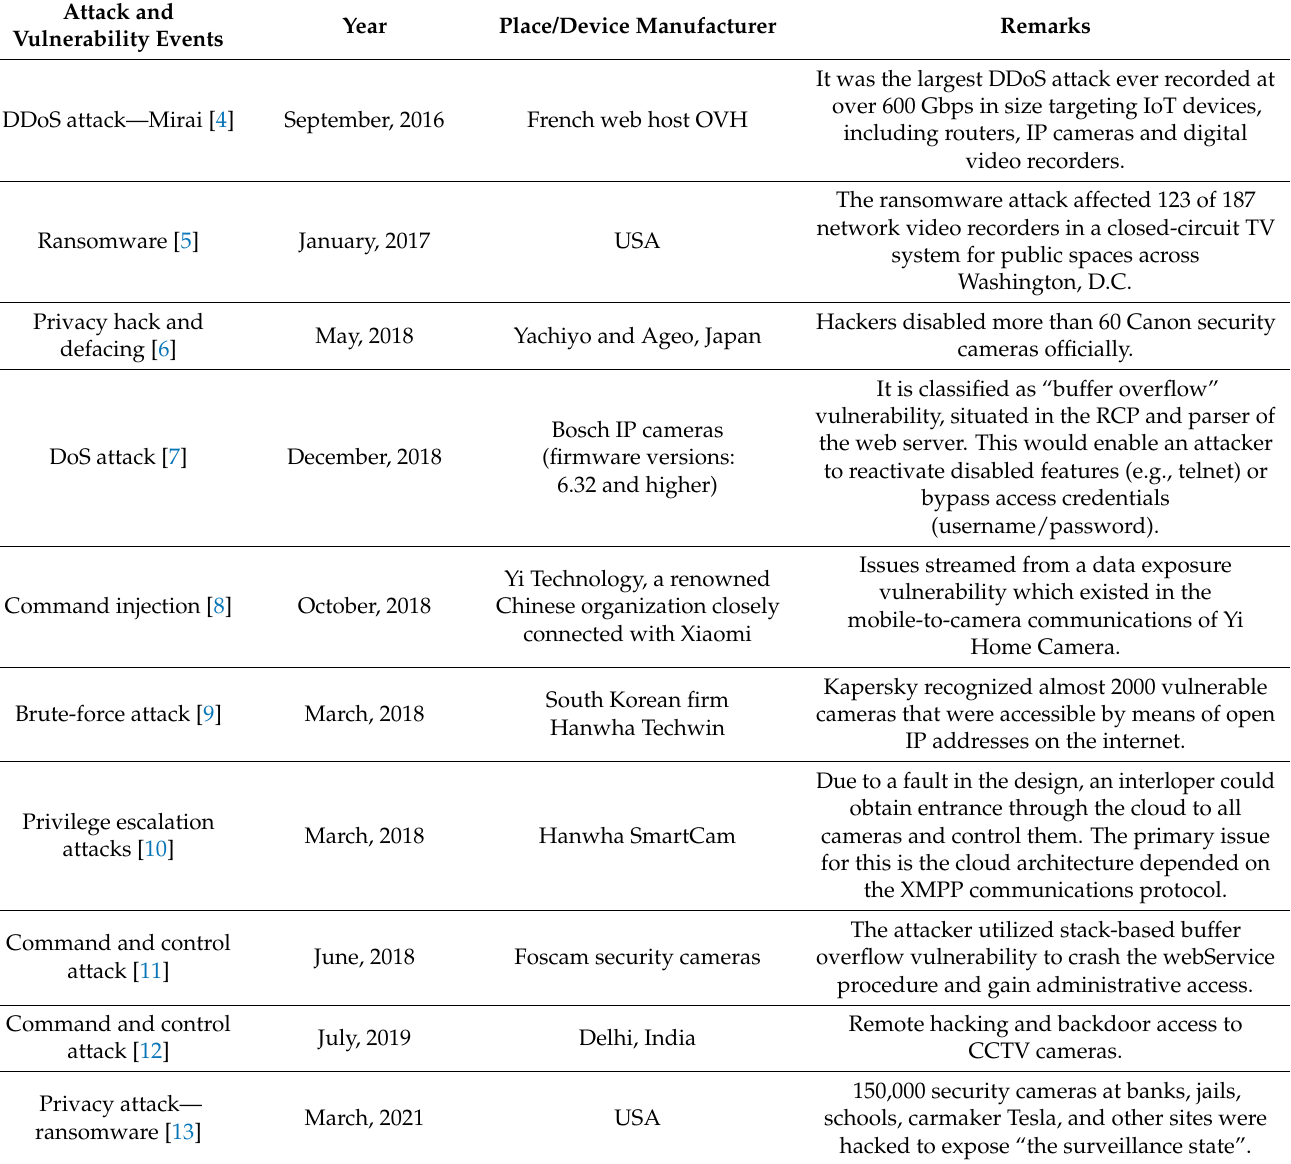
Table 1. Attack incidents and vulnerabilities on